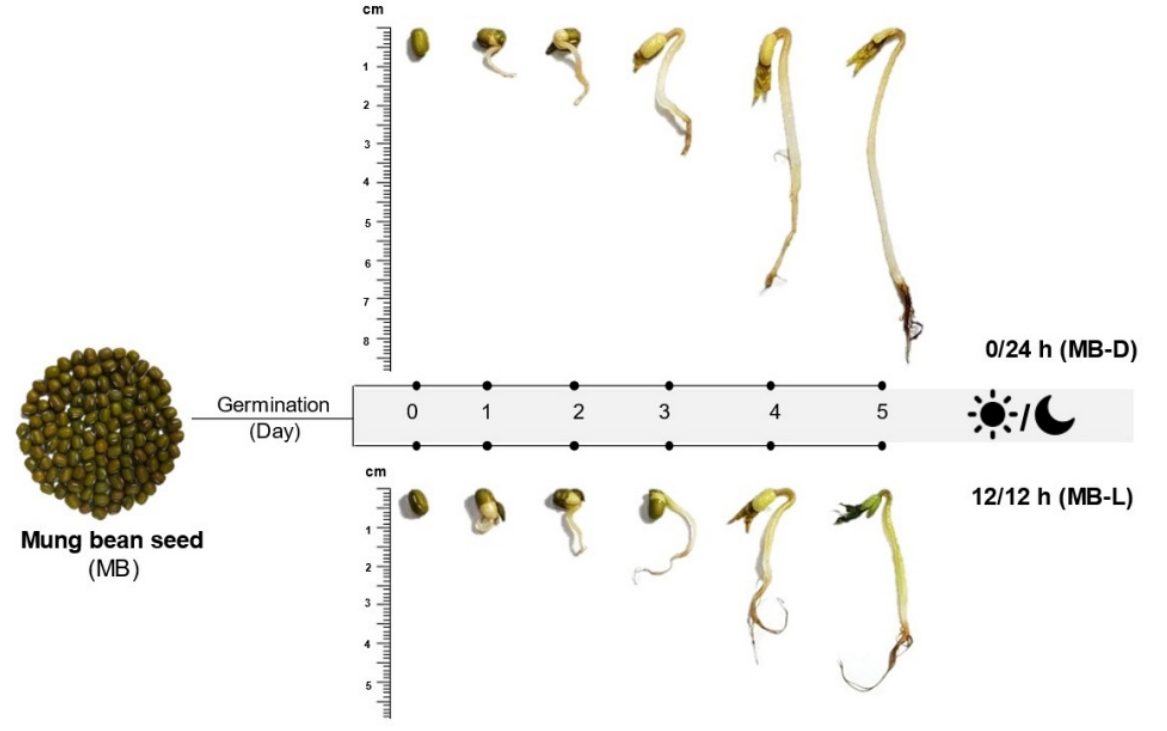
Figure 1. Appearance of mung bean (MB) seeds and sprouts in the dark (0/24 h; MB-D) and illumination (12 h/12 h; MB-L) on day 0 to day 5.